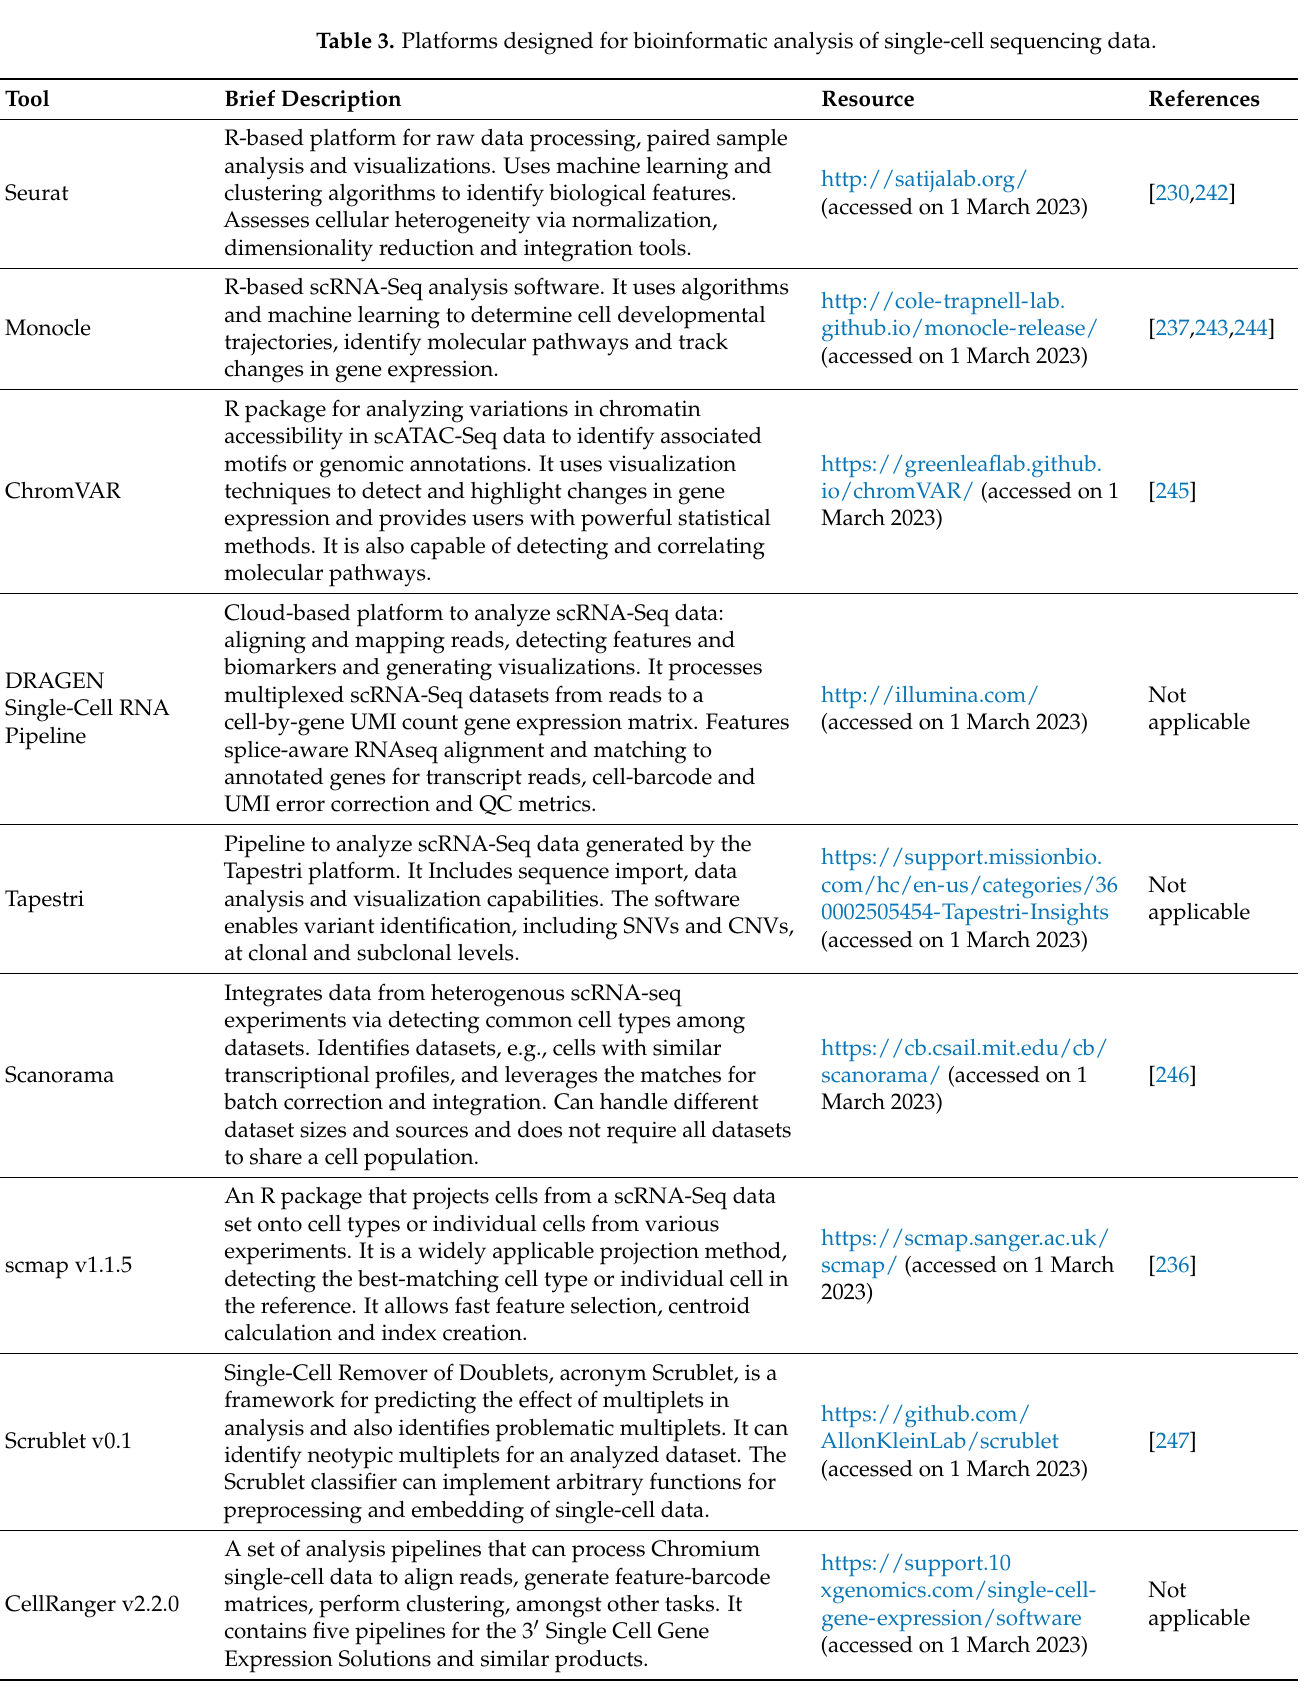
Table 3. Platforms designed for bioinformatic analysis of single-cell sequencing